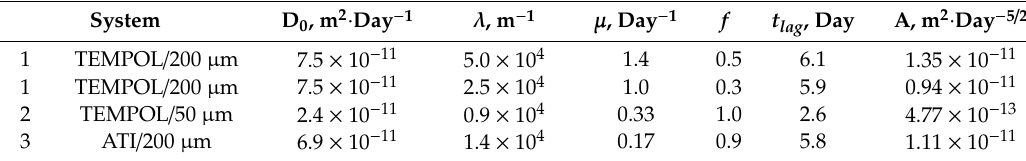
Table 3. The optimal values of the modeling parameters.